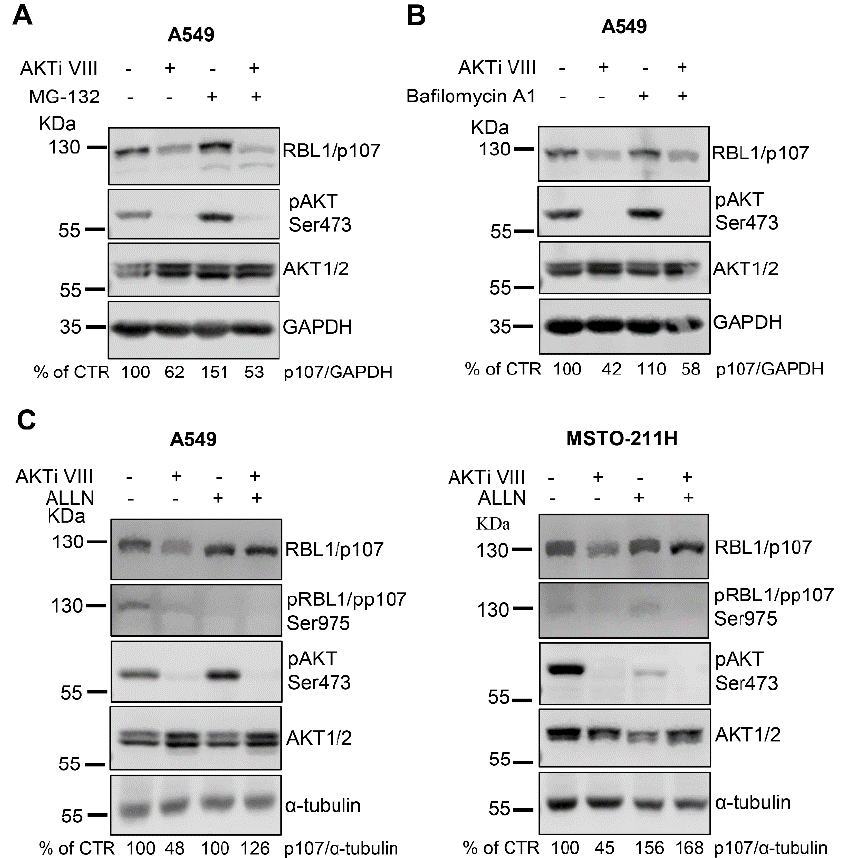
Figure 3. The inhibition of calpain stabilizes RBL1/p107 protein levels, which is not affected by either proteosomal or lysosomal inhibitors. ( A – C ). RBL1/p107 levels and RBL1/p107 phosphorylation at Ser975 ( C ) were determined by immunoblot in A549 cells and MSTO-221H cells ( C ) preincubated with the proteasome inhibitor MG-132 (1 µ M) ( A ), the lysosome inhibitor bafilomycin A1 (0.1 µ M) ( B ) or the calpain inhibitor ALLN (100 µ M) ( C ), for 1 h and then treated for 16 h with 12.5 µ M AKTi VIII alone or in combination with MG-132 ( A ), bafilomycin A1 ( B ), or ALLN ( C ). Quantification was performed by densitometric analysis using the ImageJ program and expressed as % of control. All experiments were performed three times.